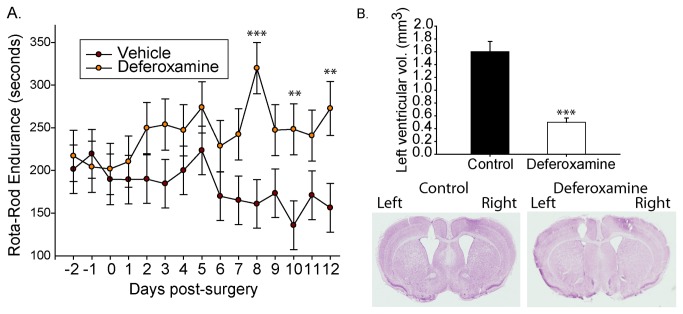
Intra-ventricular delivery of the iron chelator deferoxamine provides protection in R6/2 HD mice.Deferoxamine was delivered into the left ventricle of 6-week-old R6/2 HD mice at a dose-rate of 1-nmole / hour. Mice were analyzed daily before and after surgery for Rota-rod performance. A. Deferoxamine treated mice improve on Rota-Rod performance while vehicle-treated mice decline. B. Ventricular volumes are significantly lower in deferoxamine mice on the treated-side. P-values: **<0.01, ***<0.001: n=7.